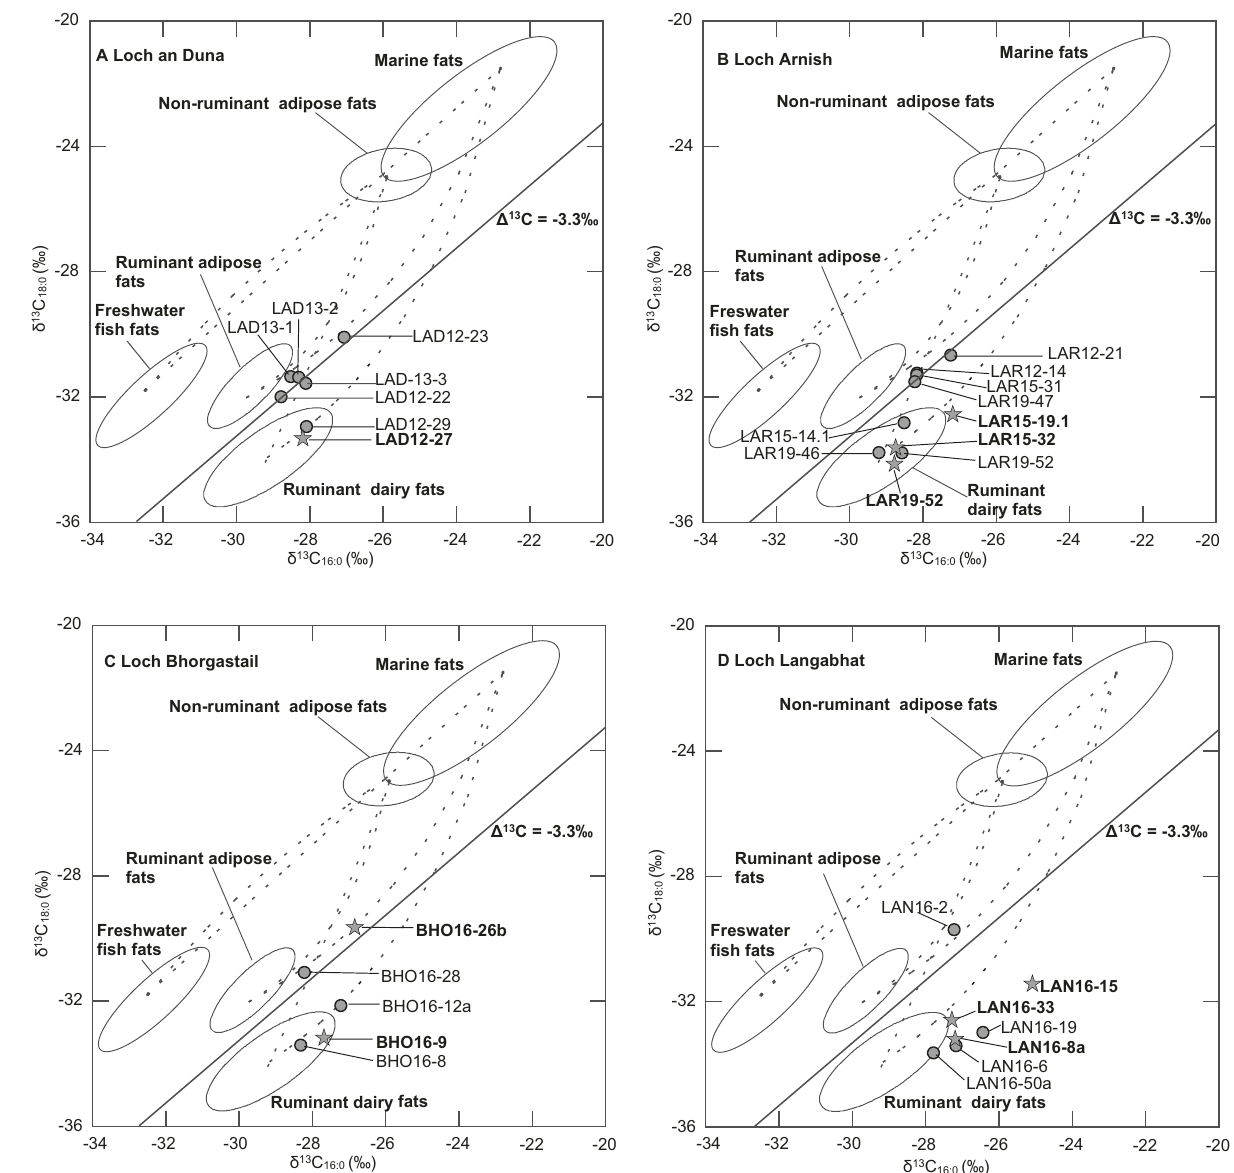
Fig. 3 | Scatter plots of δ 13 C values of C 16:0 and C 18:0 fatty acids determined by GC-C-IRMS. The plots show the δ 13 C values of C 16:0 and C 18:0 fatty acids prepared fromtotallipidextractsofthepotteryfromLochanDuna( A ),LochArnish( B ),Loch Bhorgastail ( C ) and Loch Langabhat ( D ). All δ 13 C values obtained for modern referenceterrestrialanimalfatswerefromanimalsraisedonpureC 3 diet 28 andhave been adjusted for the post-Industrial Revolution effects of fossil fuel burning, by the addition of 1.2 ‰ 47 . Reference values for aquatic fats are from marine species